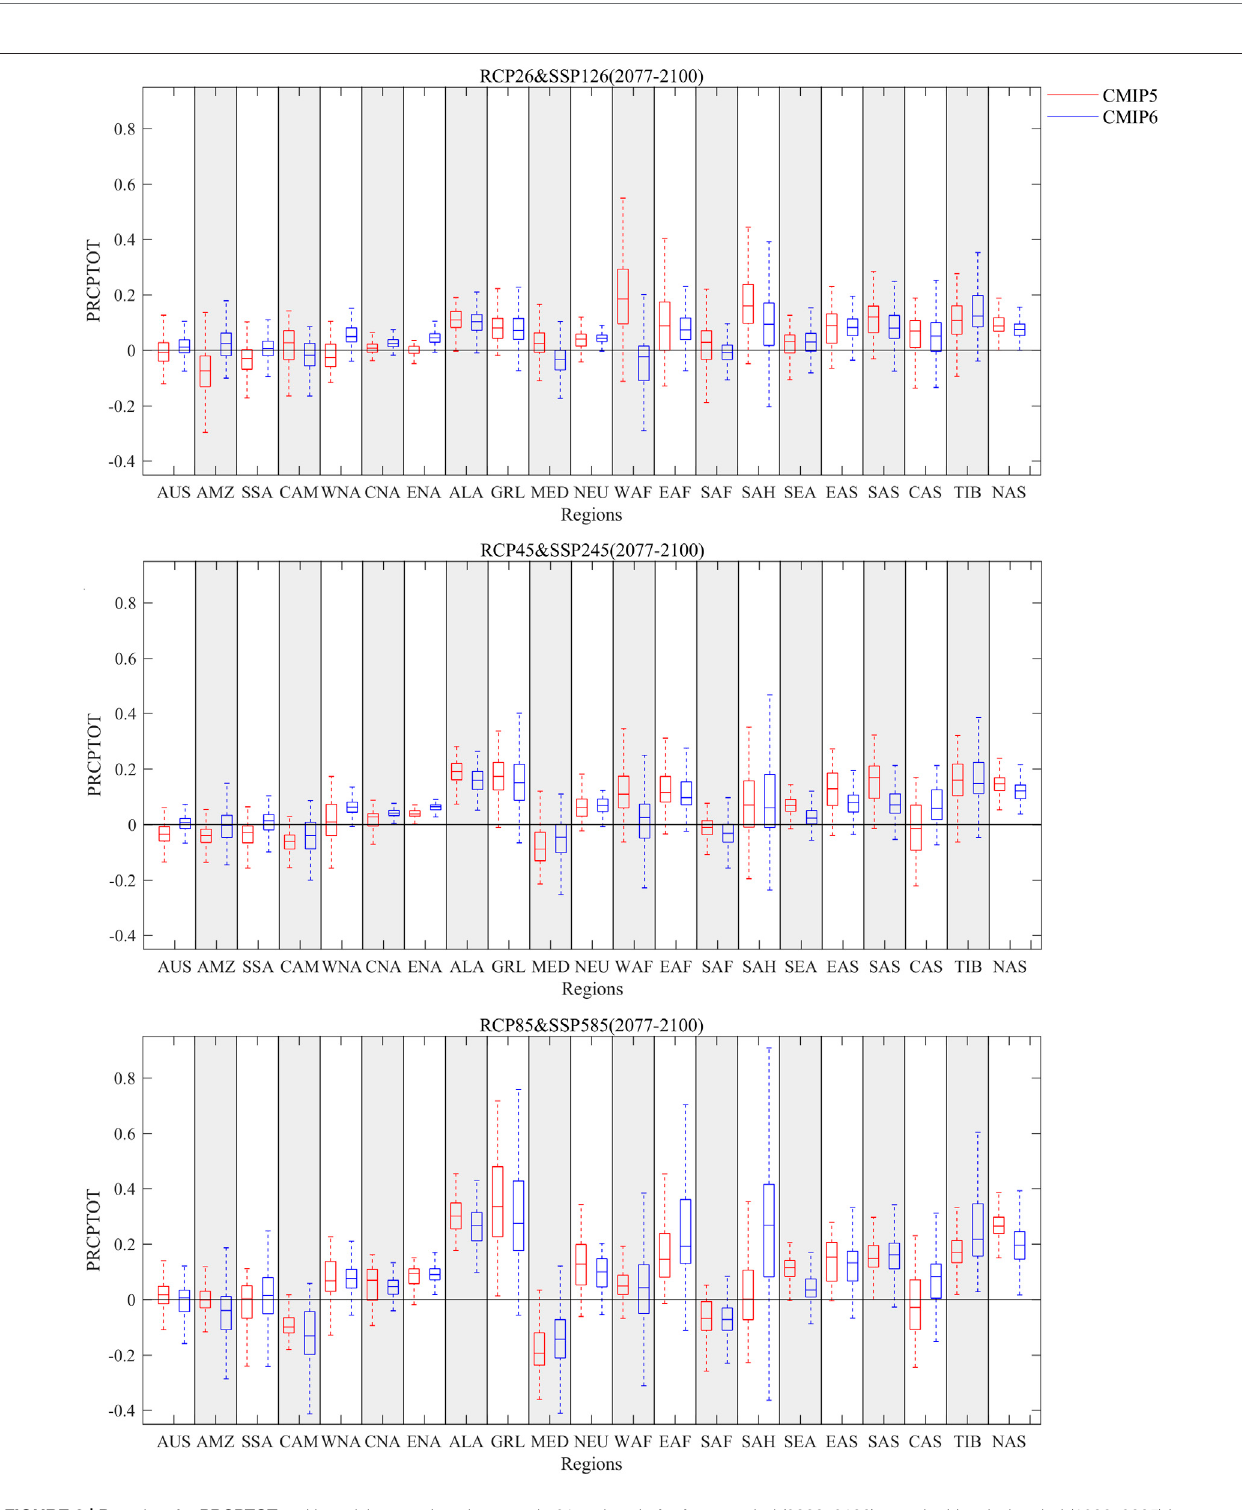
FIGURE 8 | Box plots for PRCPTOT multi-model mean changing rates in 21 regions in far-future period (2068 – 2100) over the historical period (1982 – 2005) in CMIP5 and CMIP6. CMIP5 is presented in red and CMIP6 is presented in blue.